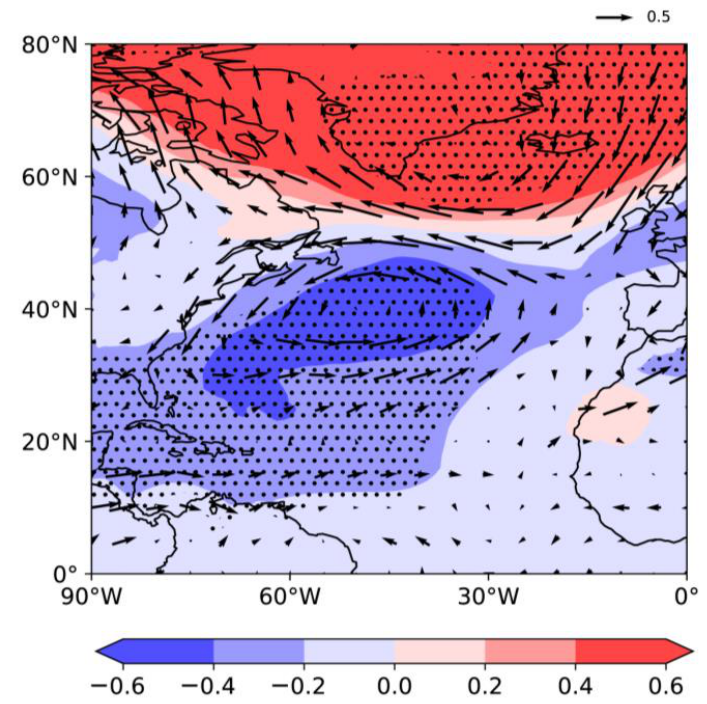
Figure 10. Regression of summer surface level pressure (shading, units: hPa) and horizontal wind at 850 hPa (vector, units: m · s − 1 ) onto the TSI. The surface level pressures significant at the 95% confi- dence level are